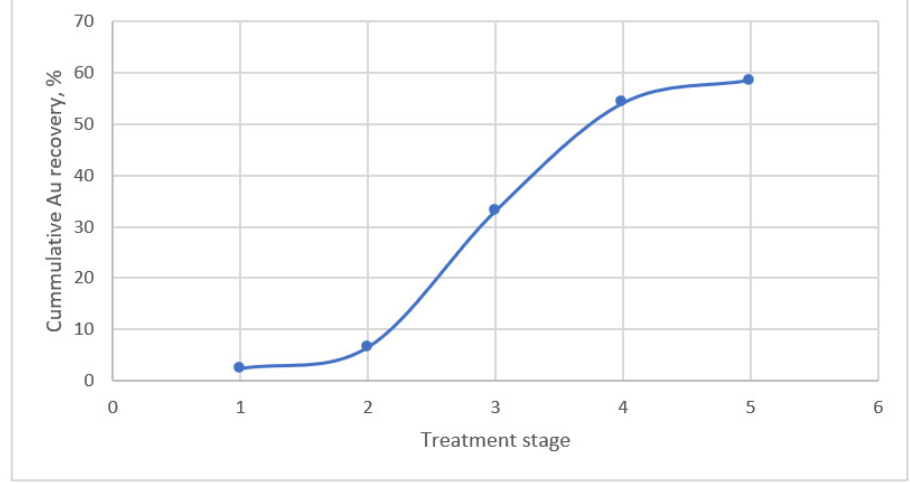
Figure 6. Cumulative recovery graph.